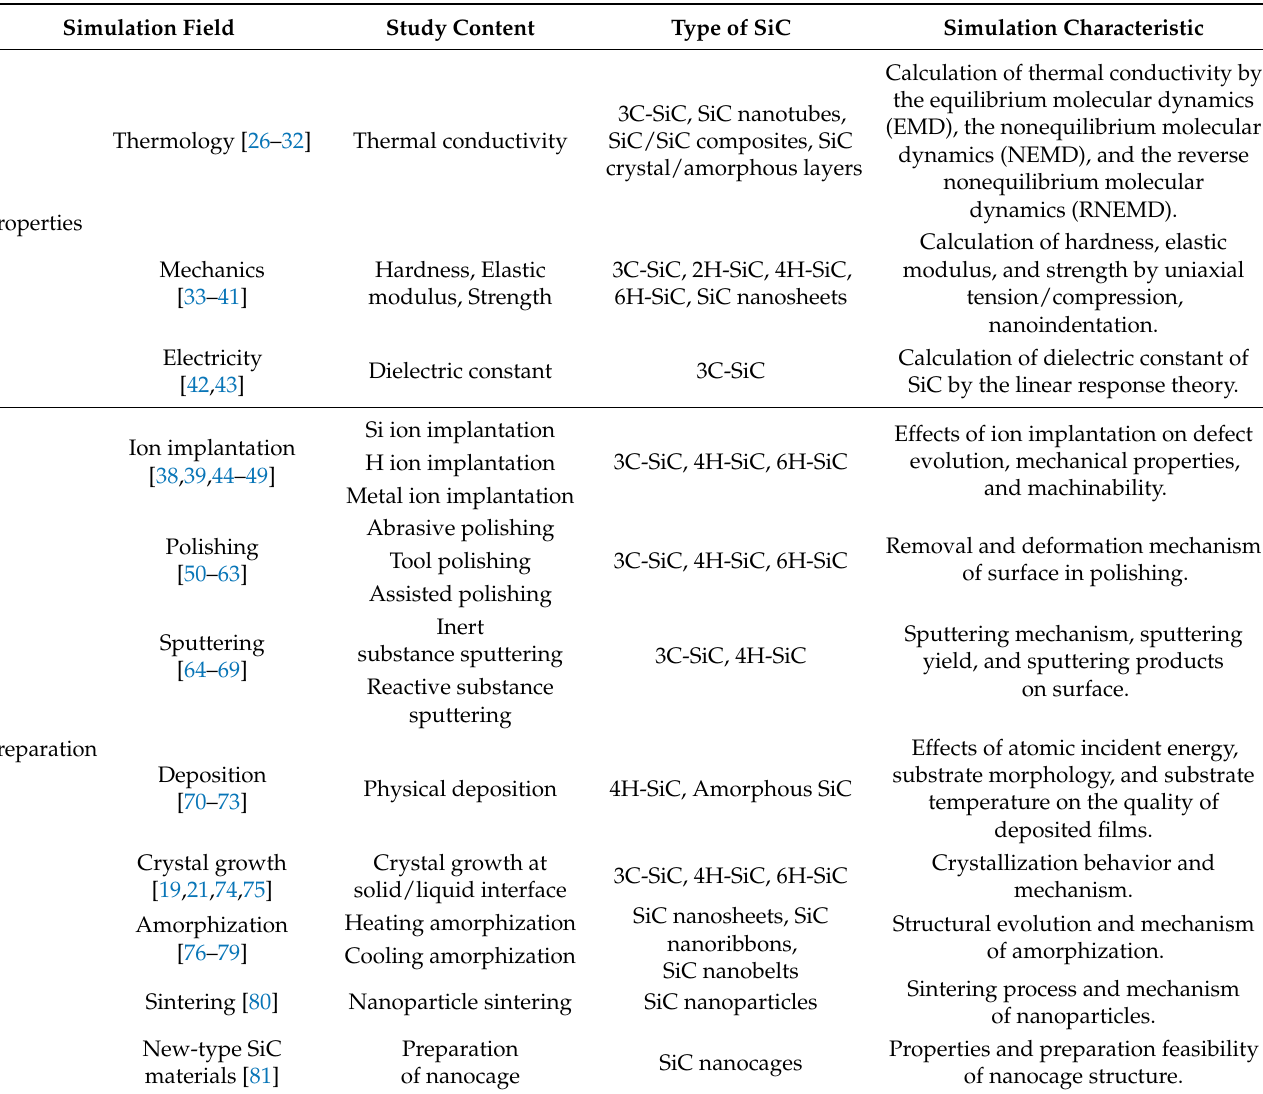
Table 2. The overview of MD simulation studies on silicon carbide